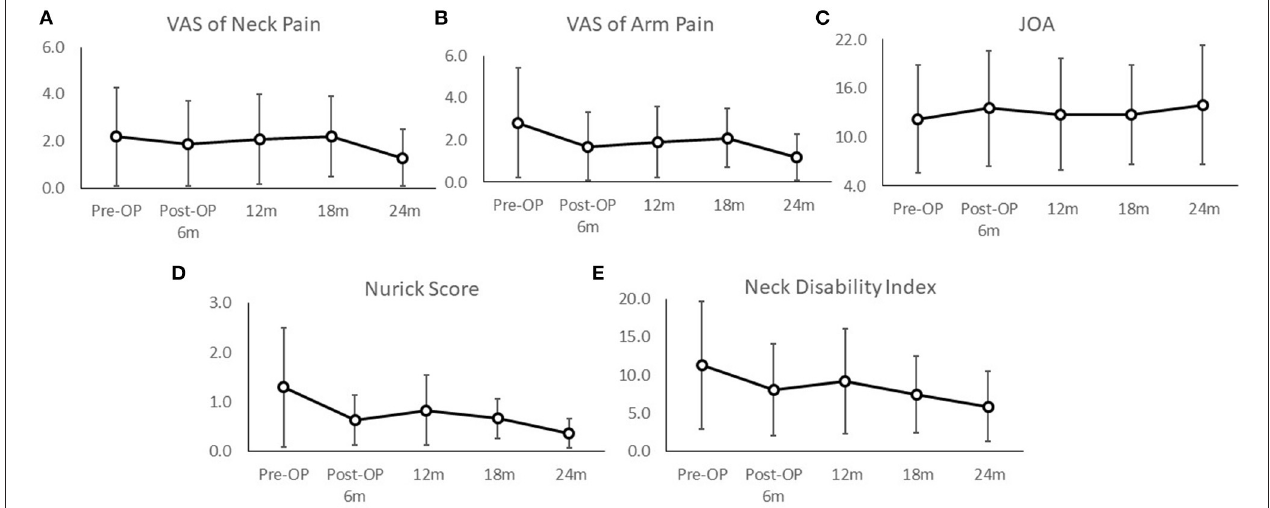
FIGURE 1 | The peri-operative and post-operative functional outcomes included the VAS scores of neck (A) and arm pain (B) , JOA scores (C) , Nurick scores (D) , and neck disability index (E) . All post-operative outcomes at 2-years follow-up had significant improvement ( p < 0.05), compared with pre-operative status. The value of each follow-up time point was illustrated by mean + /–standard